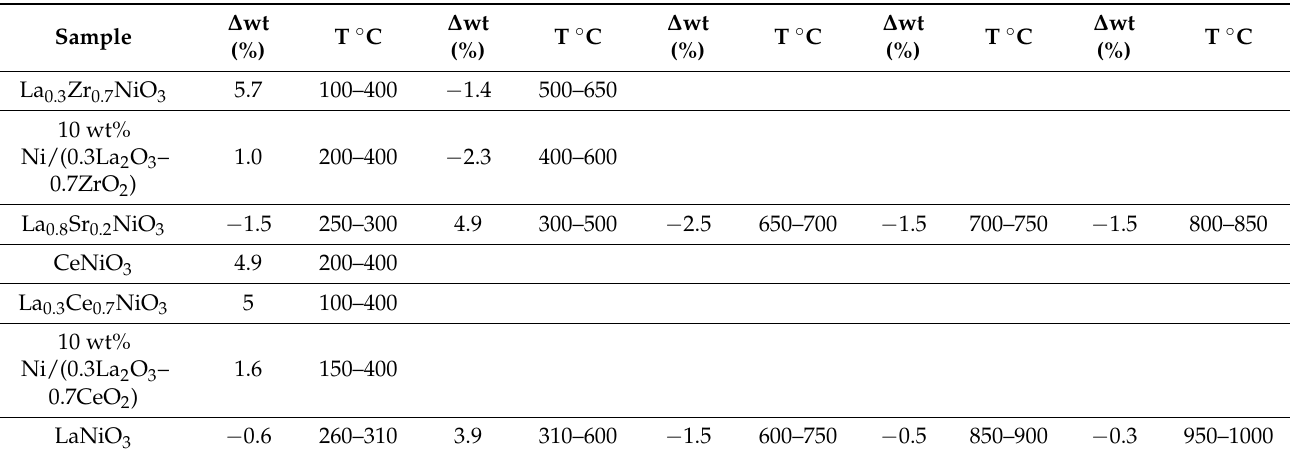
Table 2. Results of TGA. ∆ wt represents the normalised weight